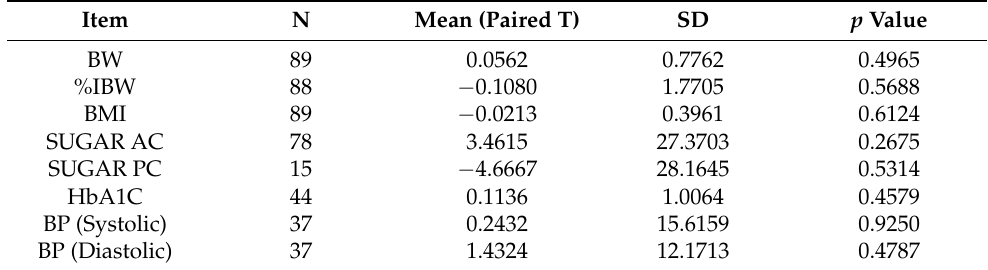
Table 4. Differences in the physical and biochemical measurements of diabetic patients before and after the health promotion program.